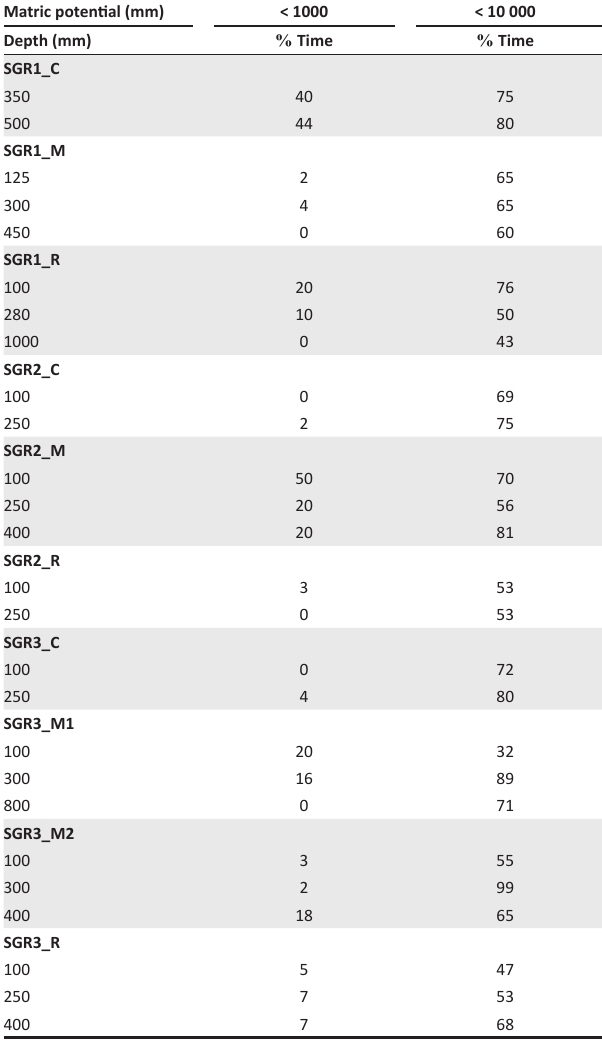
TABLE 3: Approximate duration of soil moisture at low and high matric potentials (September 2012–April